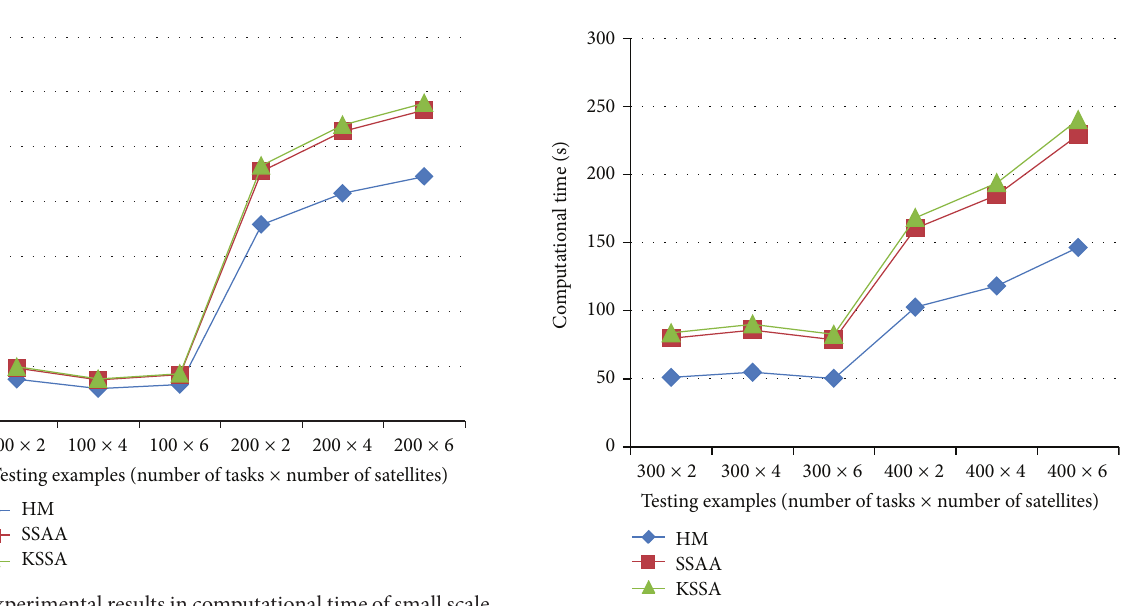
Figure 6: Experimental results in computational time of medium scale testing examples.